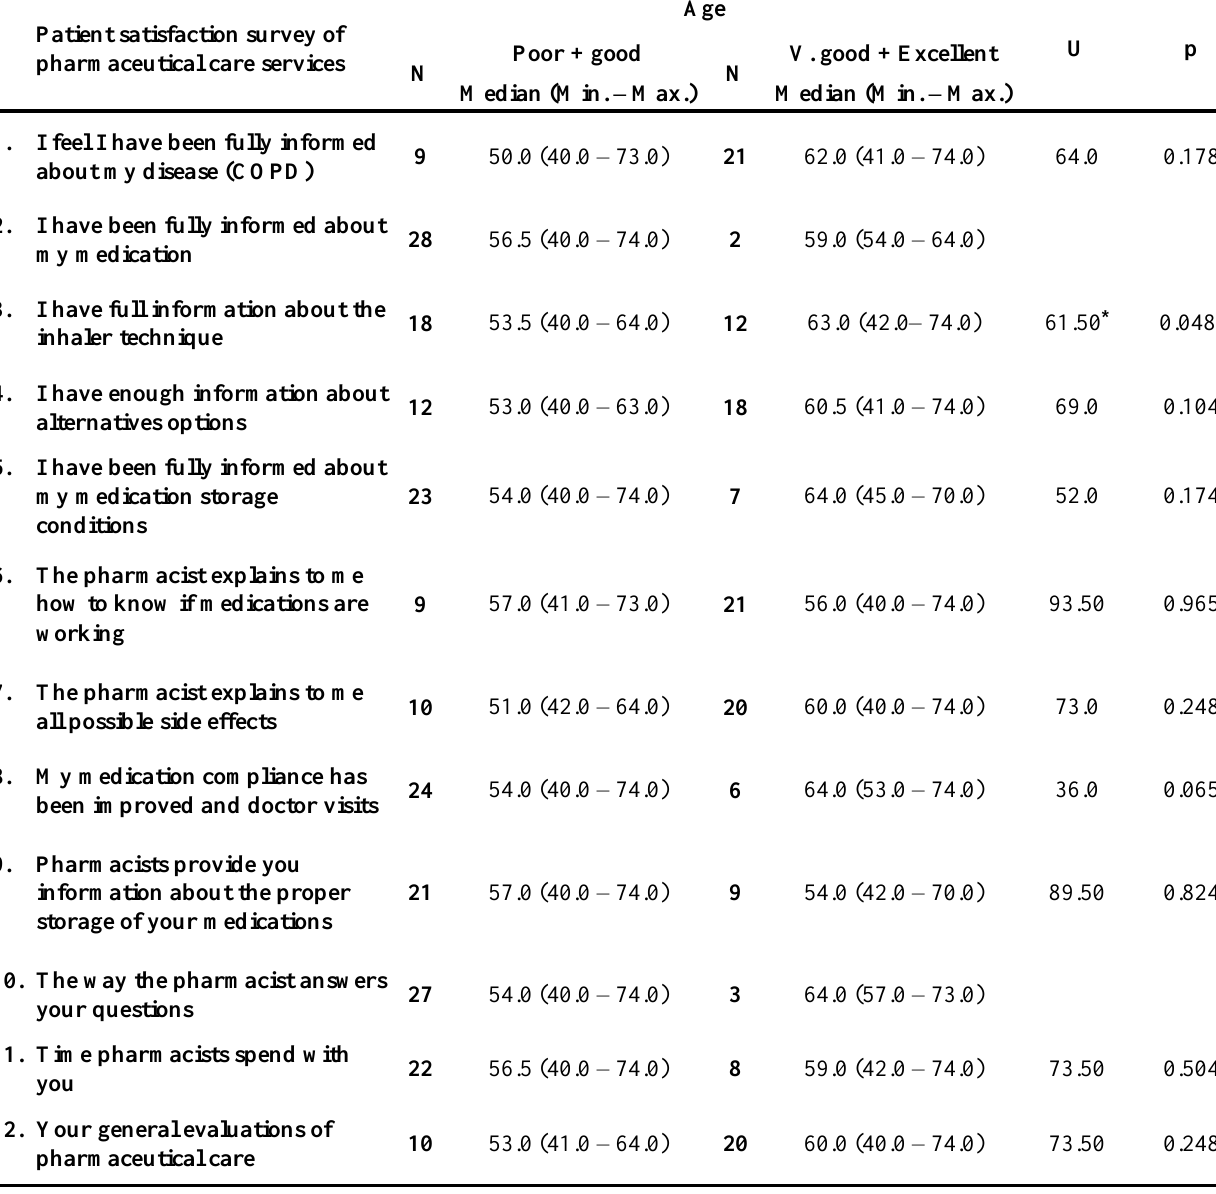
Table 2. Effect of age on patients' satisfaction towards the provided pharmaceutical care services